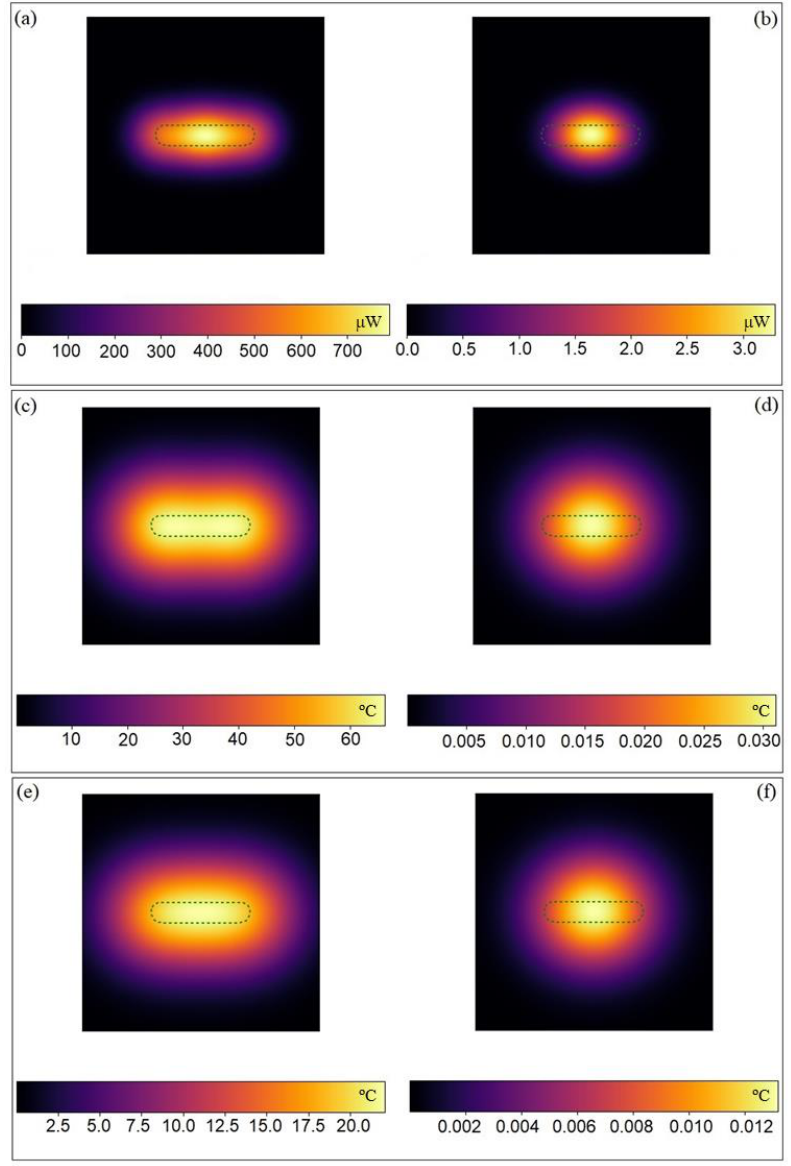
Figure 2. Released energy map from an AuNR illuminated with a laser light of 808 nm at 1 W/cm 2 for 5 min with ( a ) 0° and ( b ) 90° polarization. Heating maps of an AuNR illuminated with a laser light of 808 nm at 1 W/cm 2 for 5 min with 0° ( c , e ) and 90° ( d , f ) polarization at a distance from the observer of 5 ( c , d ) and 25 ( e , f ) nm along the perpendicular plane.